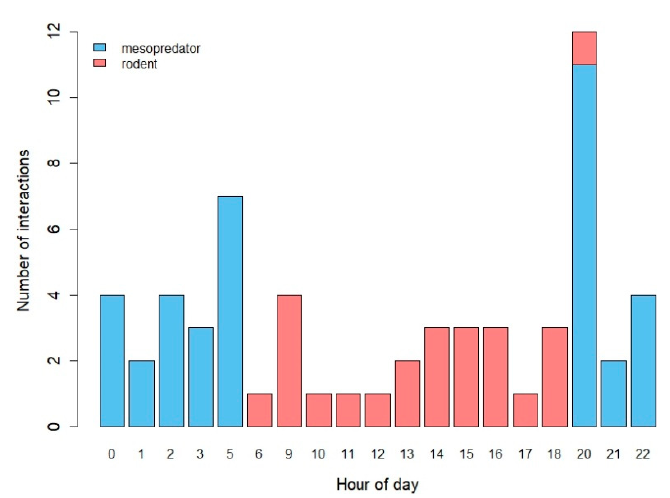
Figure 4. Number of interactions by mesopredators and rodents with three-dimensional printed turtle models by hour of day. Note some hours of day are missing due to no observed interactions during these times.